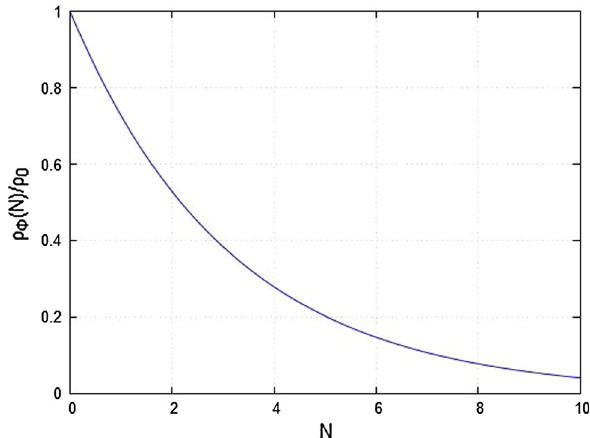
Fig. 1 Evolution of the inflaton energy density with the number of origin crossings N , as a ratio ρ density when it starts